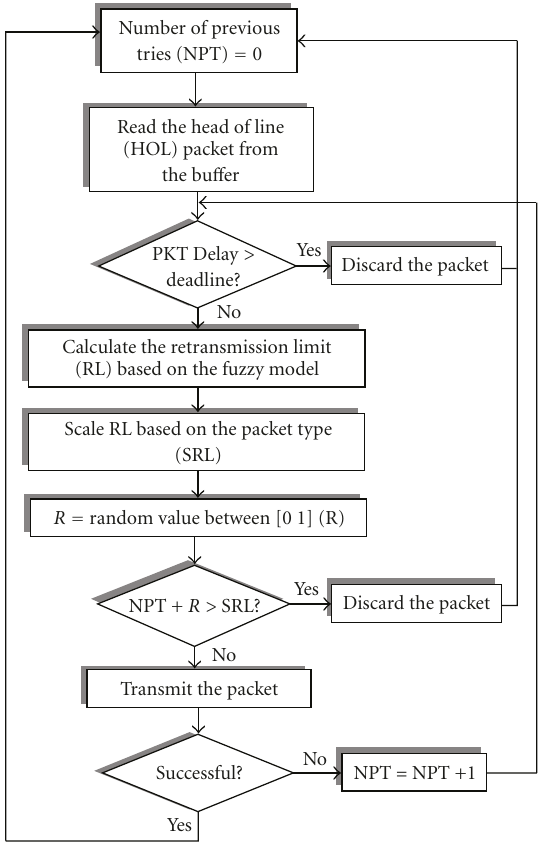
Figure 5: FLC algorithm for processing a packet.